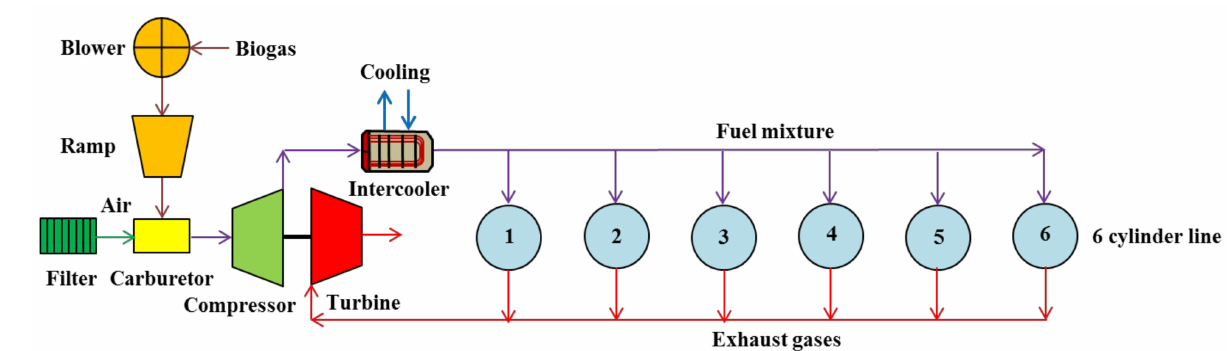
Figure 2. Scheme of one of the six cylinders’ lines of the engine. The engine has two equivalent lines.